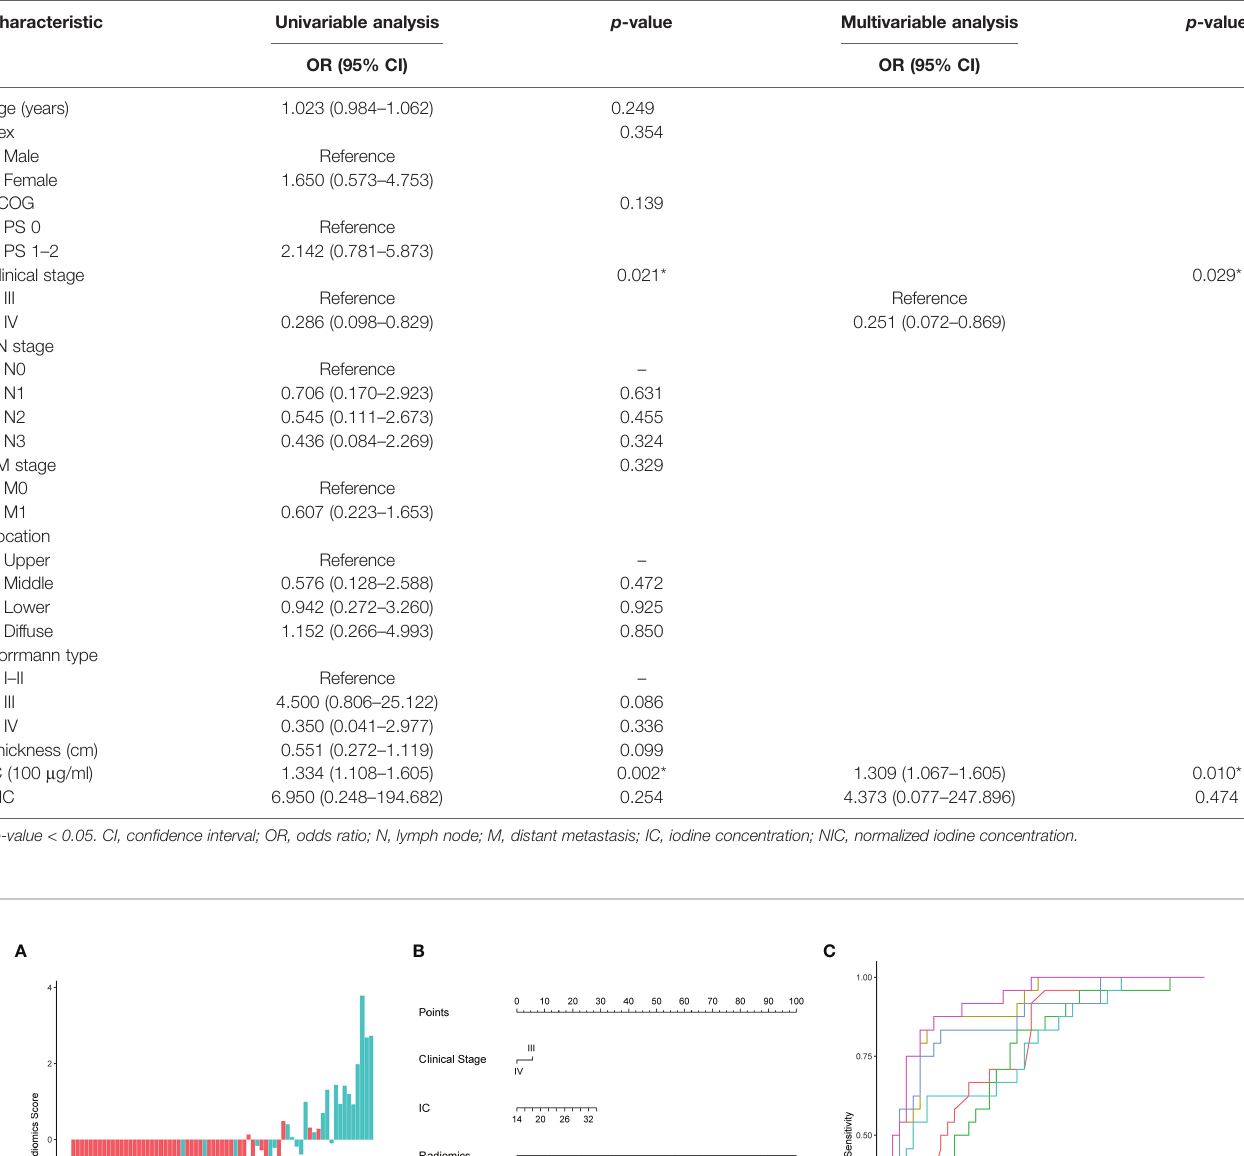
TABLE 2 | Clinical predictors for response to chemotherapy in patients with AGC.